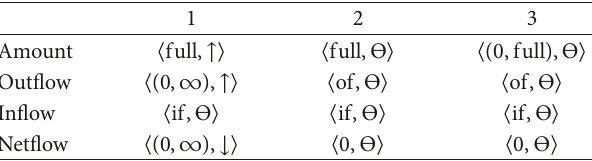
Table 4: The behaviors at 𝑡 1